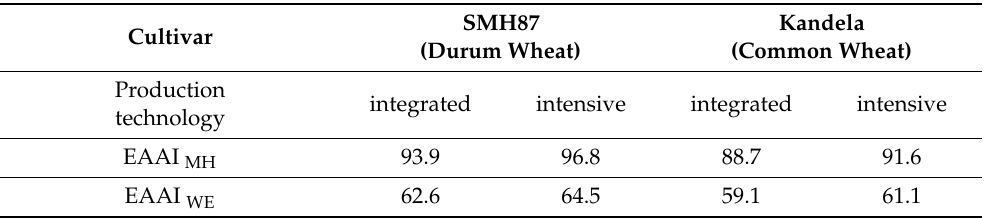
Table 4. Values for exogenous amino acids EAAI (%) depending on the production technology and